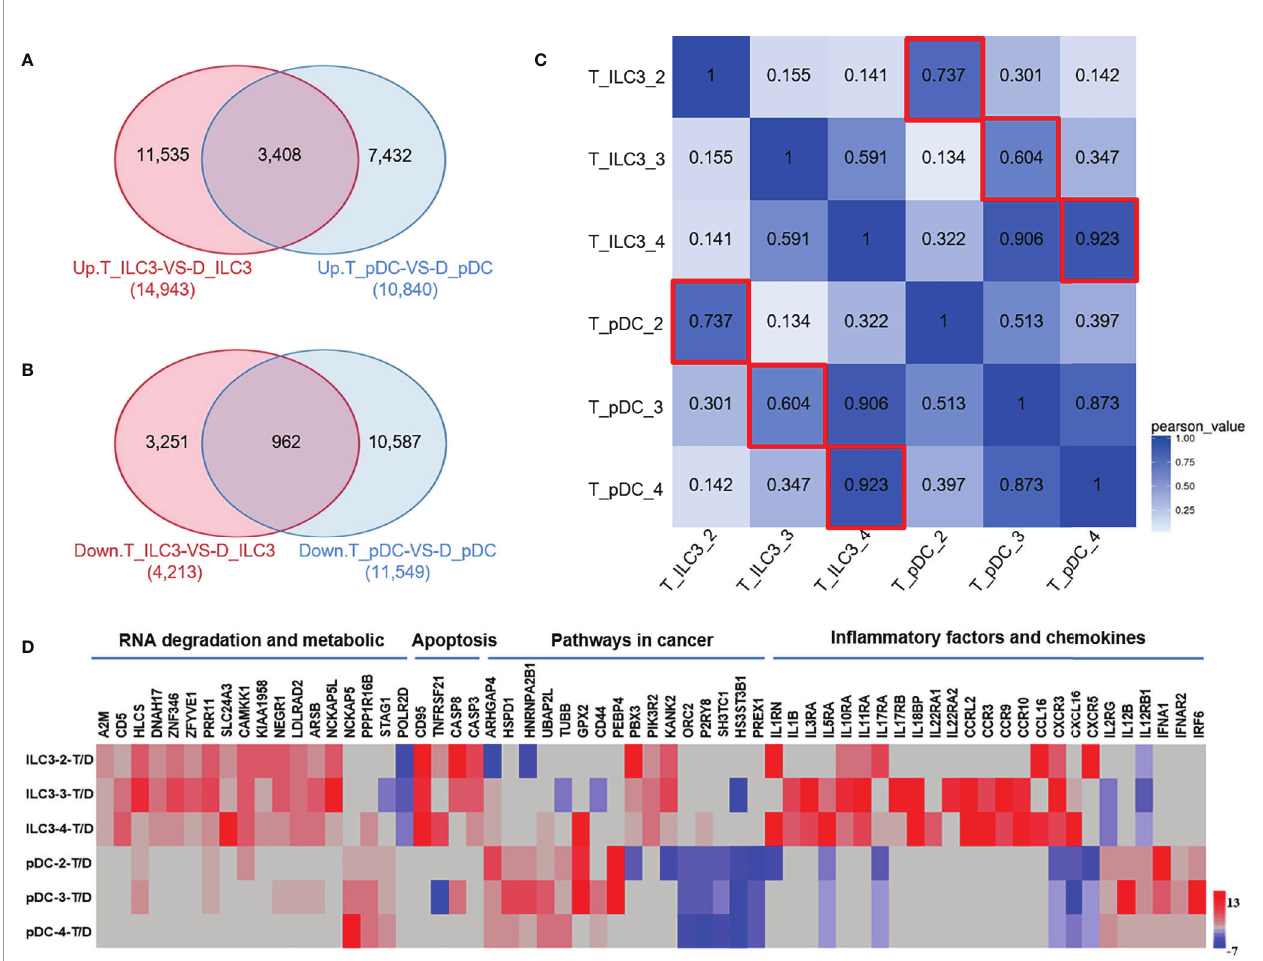
FIGURE 5 | Inverse correlation between ILC3s and pDCs in colon cancer tissues as assessed by RNA-Seq. (A) The Venn diagram represents the overlap between the number of upregulated genes in tumor ILC3s versus distal ILC3s (red, left) and tumor pDCs versus distal pDCs (blue, right). (B) The Venn diagram represents the overlap between the number of downregulated genes in tumor ILC3s versus distal ILC3s (red, left) and tumor pDCs versus distal pDCs (blue, right). (C) Heatmap of Pearson correlations between samples. Both the X and Y axes represent each sample. The colors indicate the degree of the Pearson correlation (high: blue; low: white). (D) RNA-Seq analysis of DEGs in tumor ILC3s versus pDCs. Data are from three separate comparisons of tumor ILC3s versus distal ILC3s and tumor pDCs versus distal